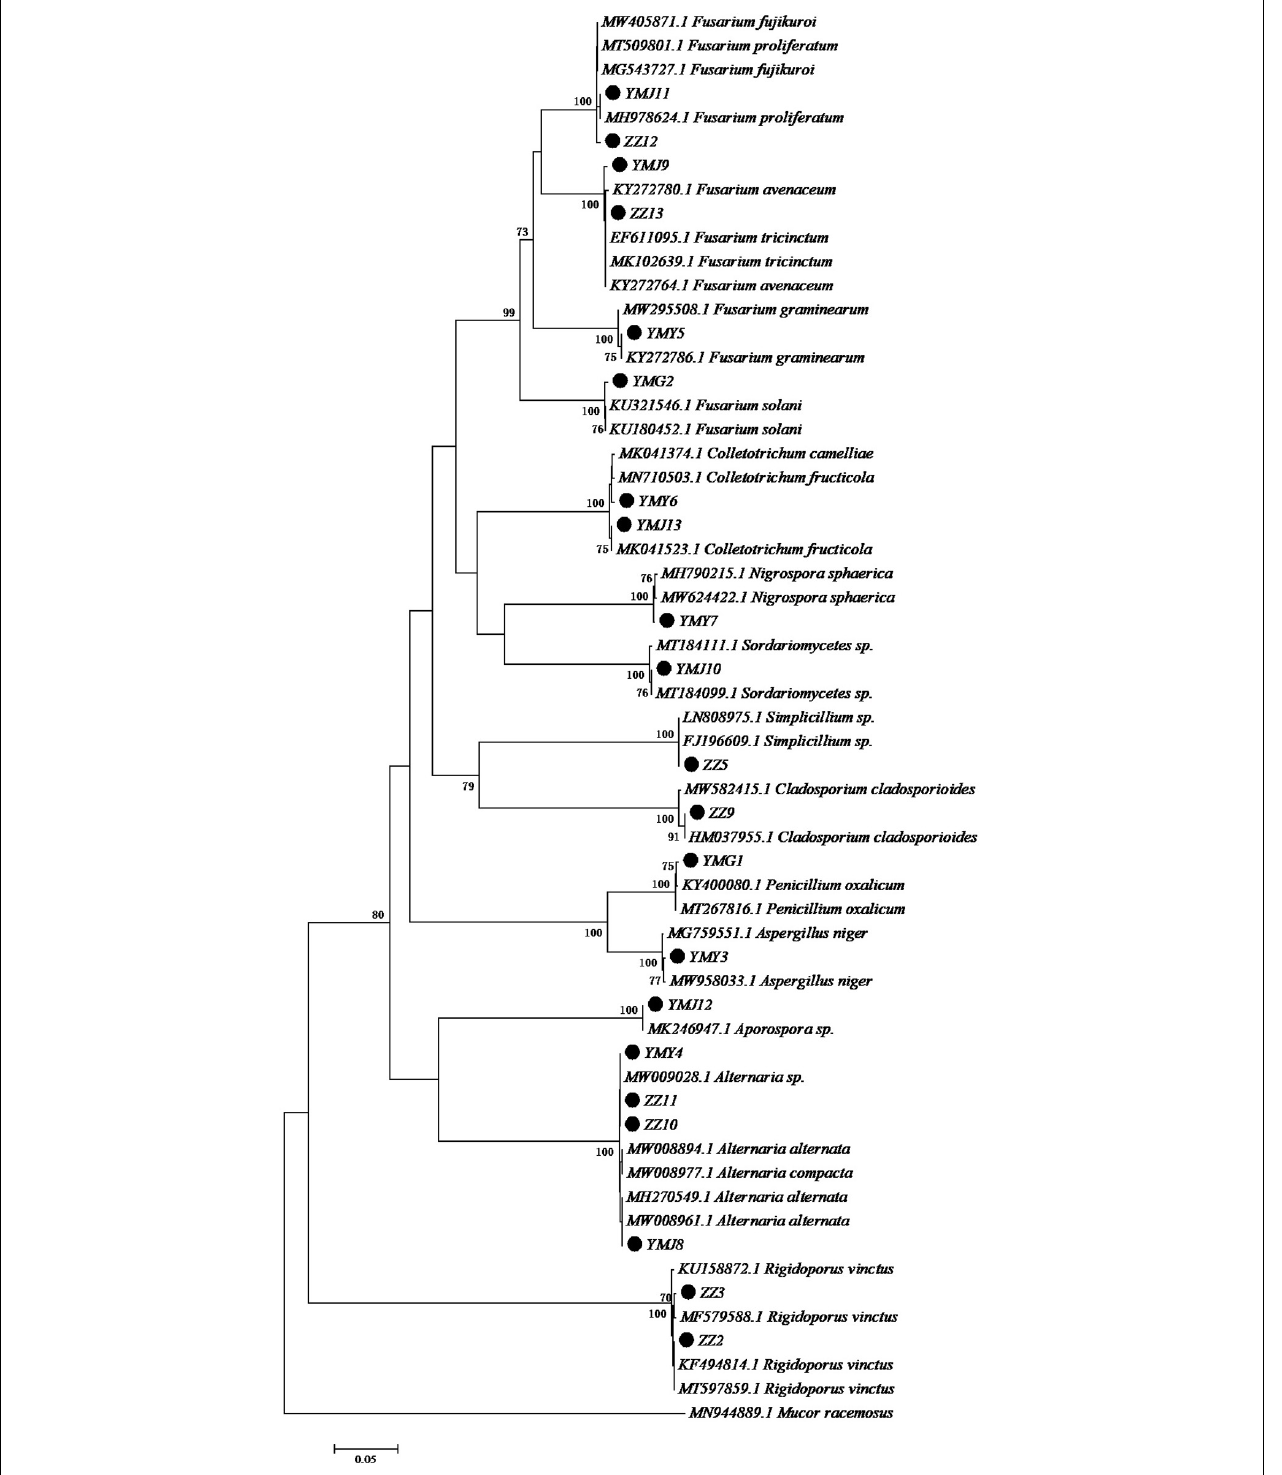
FIGURE 1 | Neighbor-joining tree of the ITS sequences of the endophytic fungi associated with CX. Numbers at nodes are bootstrap scores obtained from 1000 replications. Mucor racemosus was used as an out group.